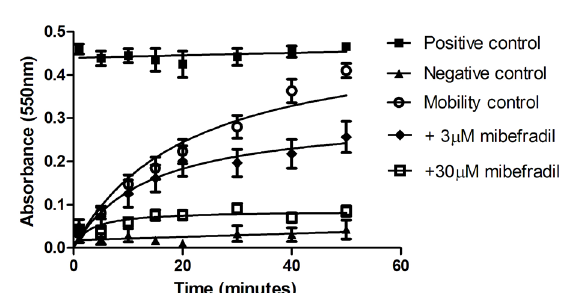
Figure 2. Mibefradil inhibits the mobility of non-capacitated boar sperm. Under control conditions sperm penetrate the Accudenz solution with a Km = 20.9 ± 3.5 min (mobility control, 14 replicates). From 10 minutes onwards mibefradil (30 m M) containing Accudenz solution significantly (P<0.05 at 10 minutes) inhibits cell mobility (17 replicates). Data are analysed using ANOVA followed by Tukeys post- hoc test. Data sets are an average of 4 ejaculates from different boars with pooled replicates as indicated. Positive and negative control data sets are an average of 4 ejaculates measured in quadruplicate.